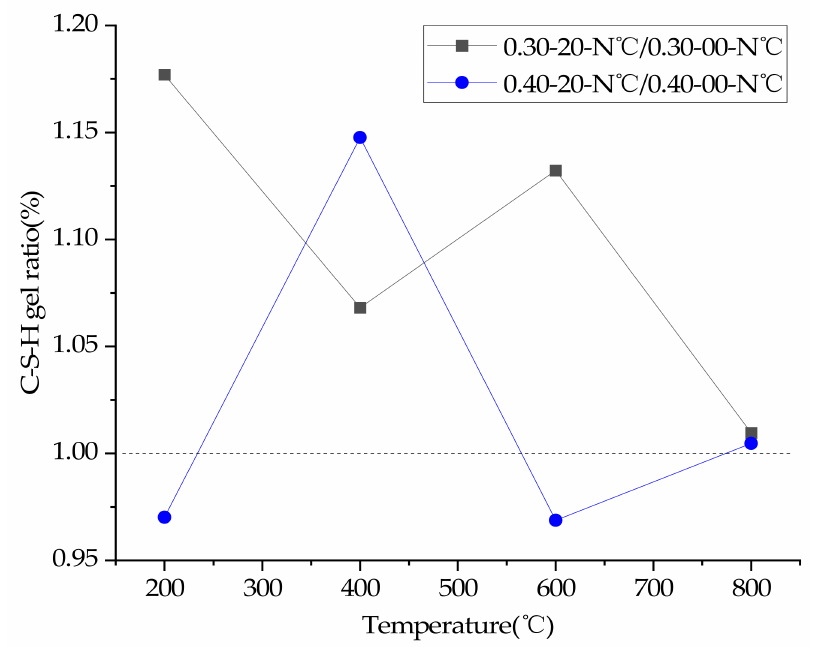
Figure 10. C-S-H gel content ratio of concrete